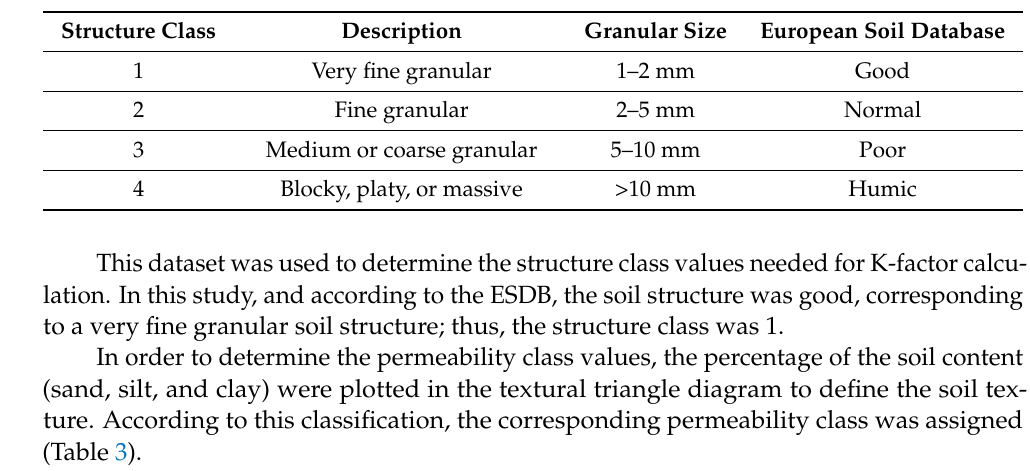
Table 2. Soil structure according to the European Soil Database.